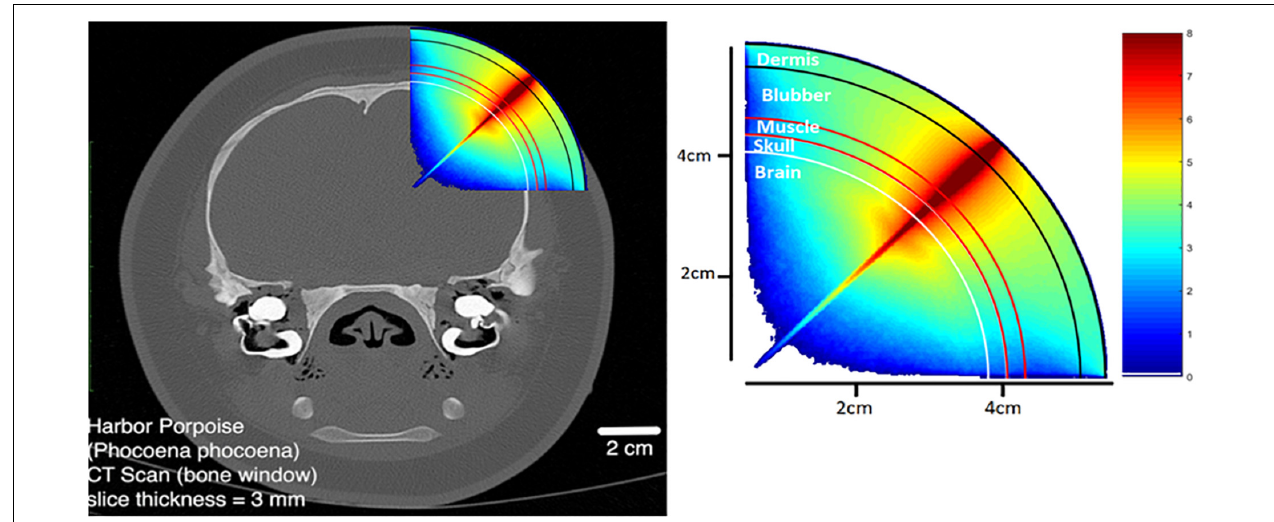
FIGURE 1 | Monte Carlo photon propagation simulation using a point LED source incident at an angle normal to the scalp. Anatomy modeled on the harbor